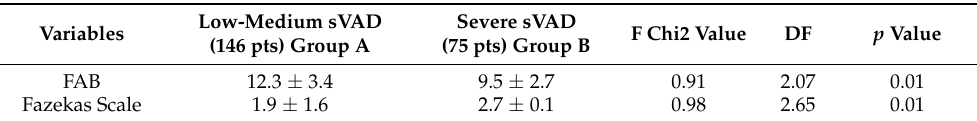
Table 3. Parameters (mean value and SD) of the defined neuropsychological scores in our